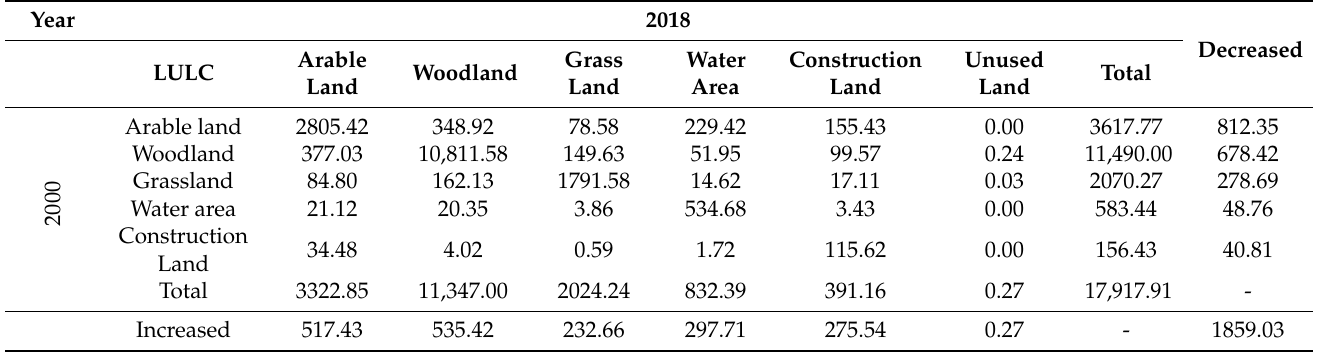
Table 2. Land use transition in the Danjiangkou reservoir area from 2000 to 2018 (km 2 ).